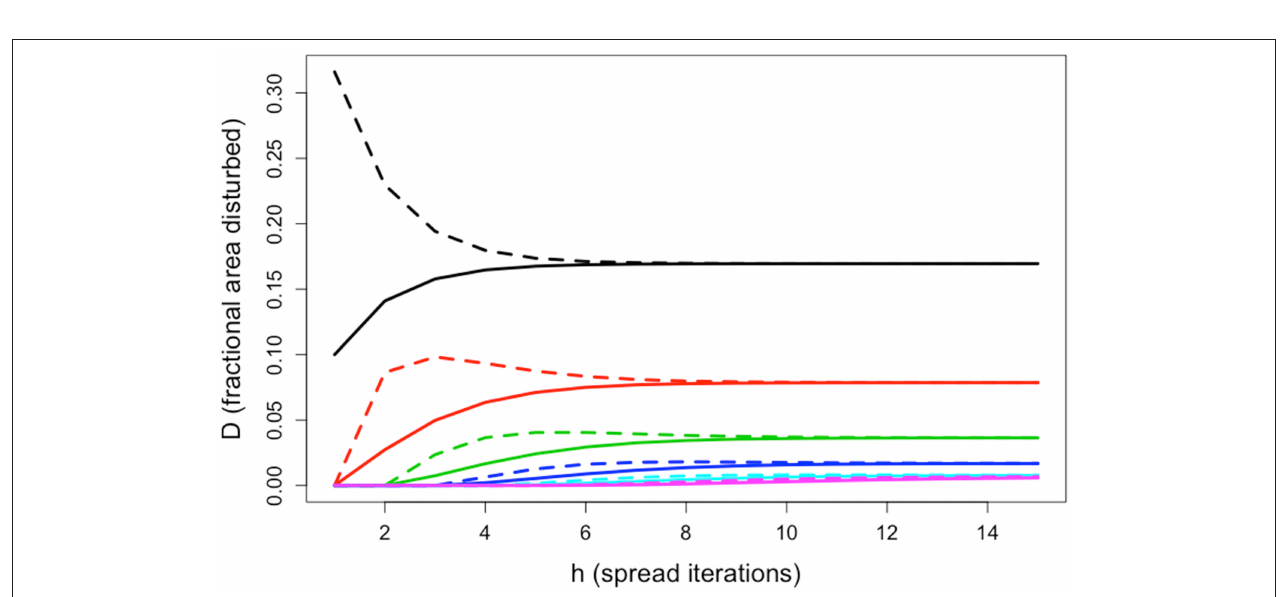
FIGURE 2 | Validation of the analytical model’s ability to predict disturbance area as a function of spread probability (disturbance initiation probability of 1%). Simulations run on a 4-sided grid so, for example, a 0.25 spread probability corresponds to four independent chances, each 25%, to spread. The analytical approximation appears to underestimate disturbance at high spread